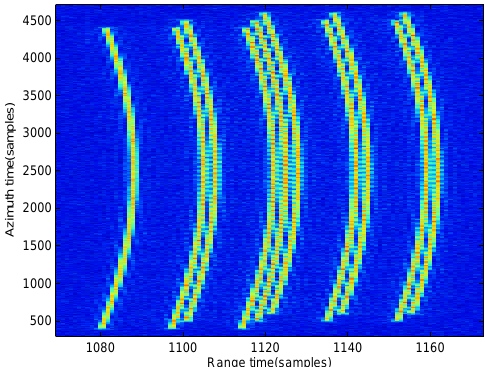
Figure 5. Keystone transform processed data in range-compressed domain.